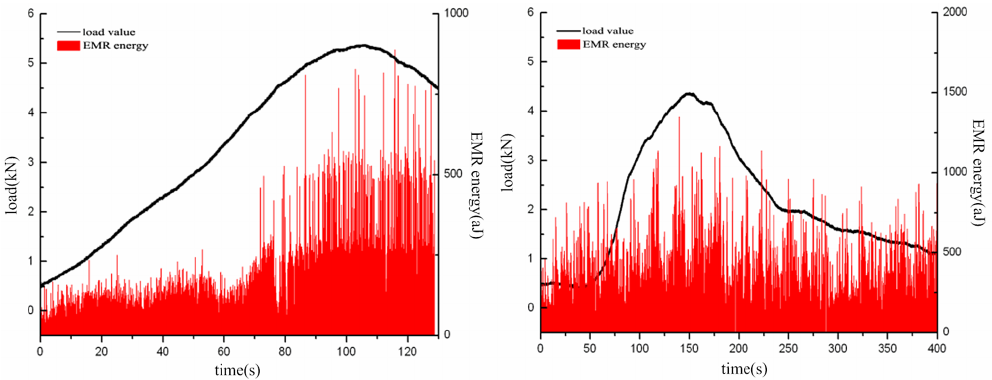
Figure 11. Changes in EMR from the coal rock unit and their combination. (a) EMR from a coal rock unit at loading rate of 0.1mmmin − 1 ; (b) EMR from complex coal rock composed of four coal and rock units at loading rate of 0.1mmmin − 1